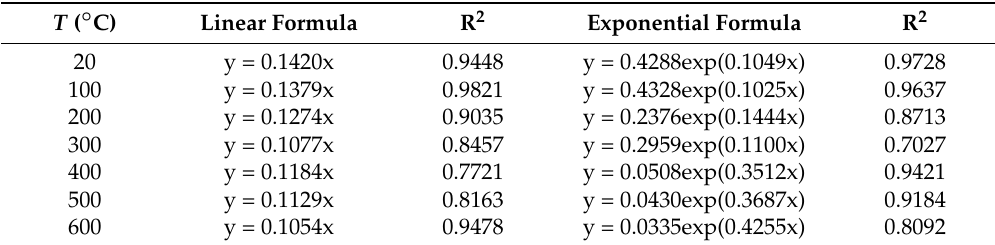
Table 3. Fitting formulas for different temperatures